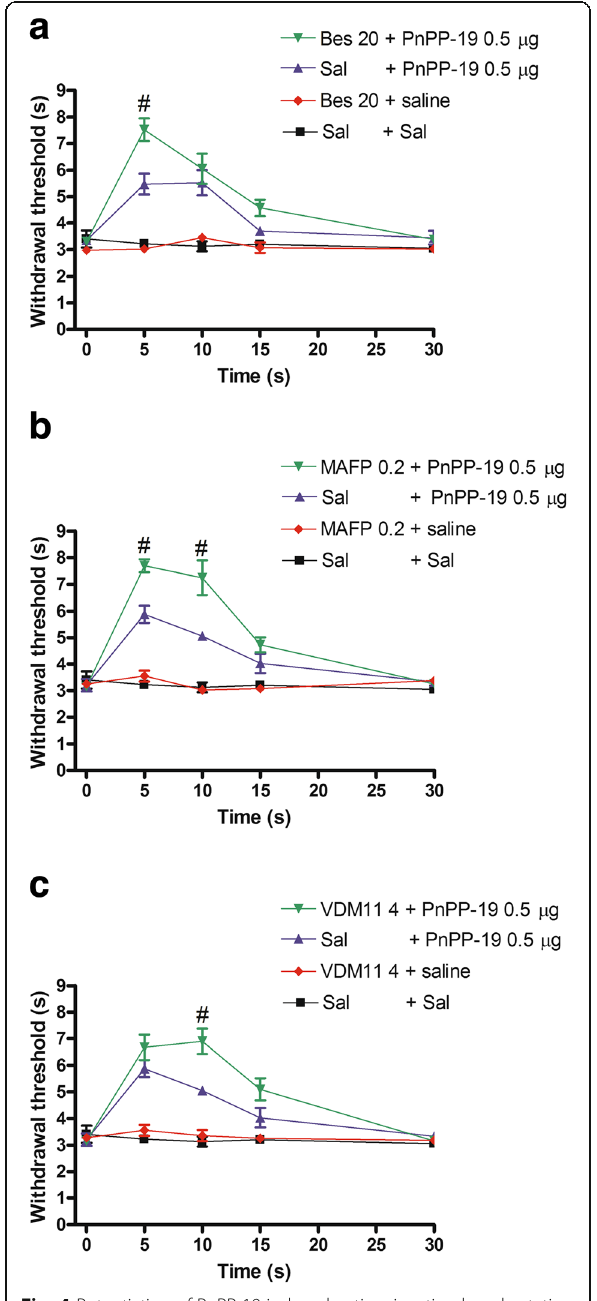
Fig. 4 Potentiation of PnPP-19-induced antinociception by a bestatin, b MAFP or c VDM11. The bestatin (Bes; 20 μ g), MAFP (0.2 μ g) or VDM11 (4 μ g) was administered 1 min prior to PnPP-19 (0.5 μ g) injection. These drugs administered alone did not induce any effect. Each line represents the mean±SEM for four mice per group. #Significant difference compared to the Sal +PnPP-19-injected group (ANOVA+ Bonferroni ’ test; p <0.05). Sal: saline (0.5% of Evans